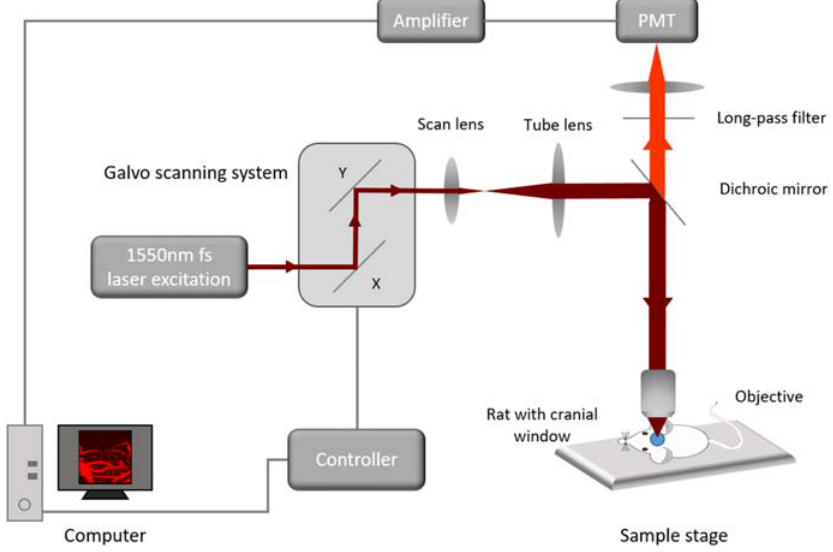
Fig. 7. Schematic illustration of the upright three-photon °uorescence scanning